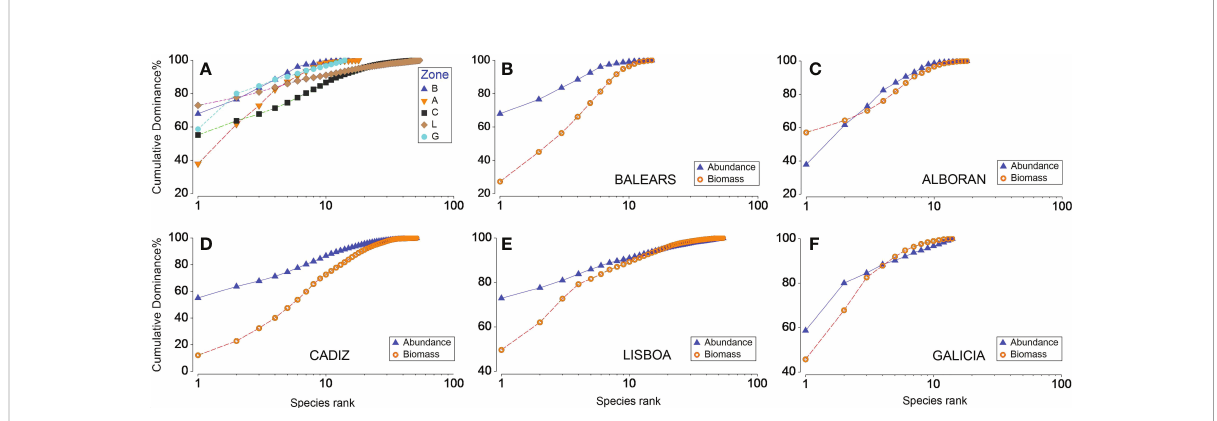
FIGURE 4 (A) Abundance k-dominance plots by zone (B: Balears, A: Alboran, C: Cadiz, L: Lisboa, G: Galicia), and (B – F) combined abundance and biomass dominance plots for the fi ve zones. The species are ranked in order of importance in terms of abundance, or biomass, on the x-axis. The y-axes indicate cumulative percentage